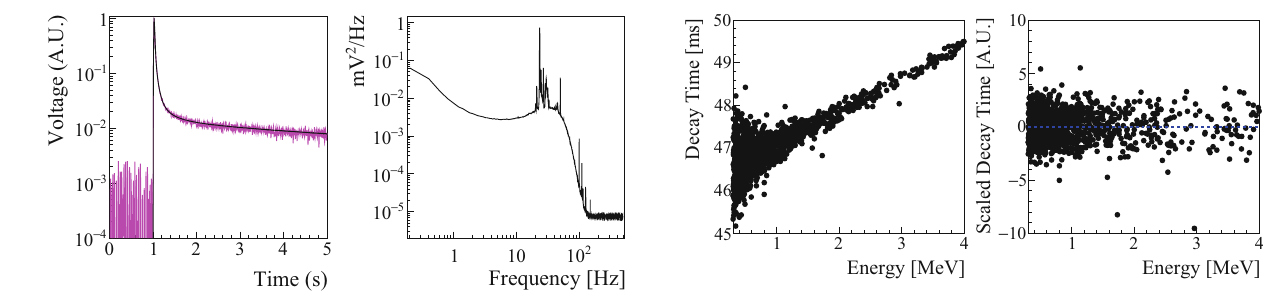
Fig. 1 Left: a typical template of a ZnSe response (black line) over- lapped to a single pulse acquired by the same detector (magenta line). Thesignaltemplatewasevaluatedaveraginghundredsofpulsesinorder to suppress the random noise fluctuations. Right: the typical average noise power spectrum of a ZnSe detector. The microphonic noise picks and the roll-off due to the anti-aliasing active Bessel filter are clearly visible